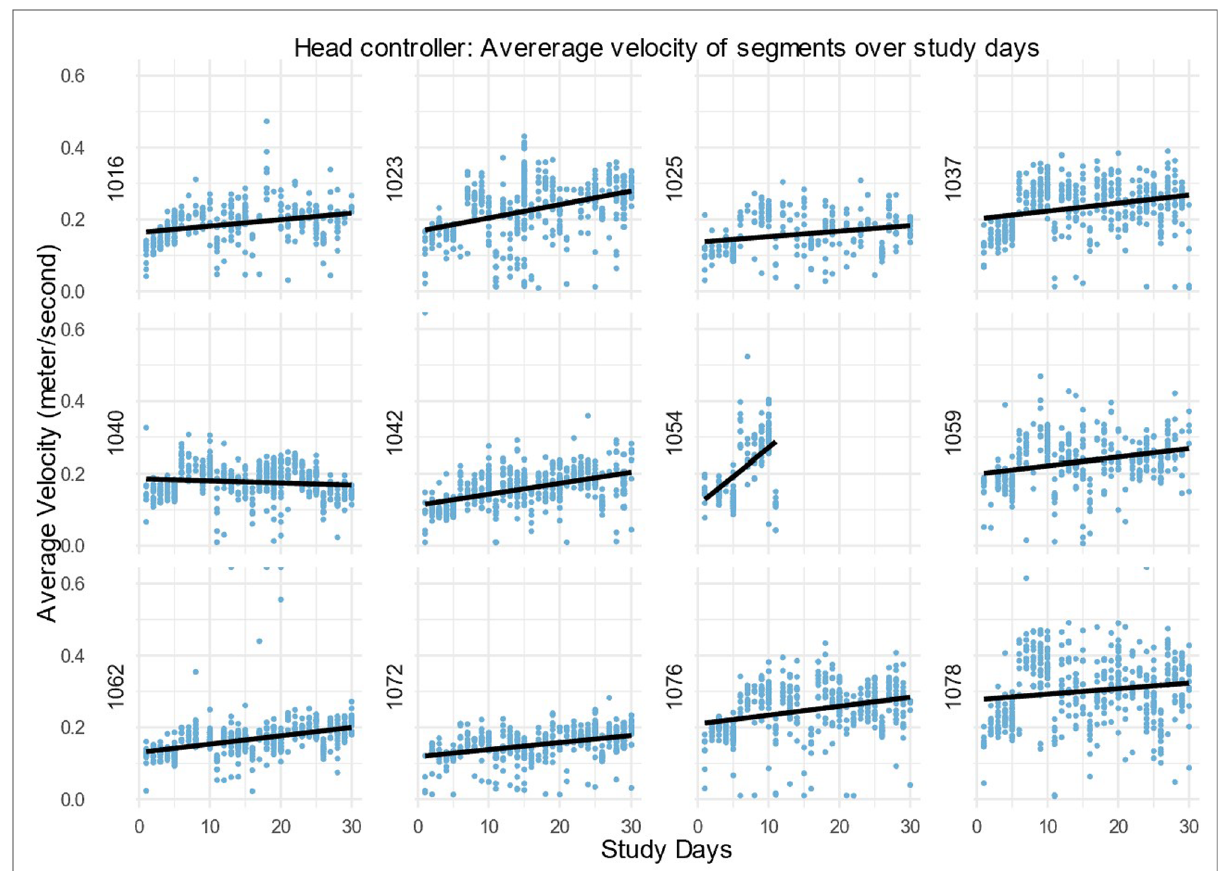
FIGURE 6 Average velocity in the head controller of all action task segments within the 30 daily sessions (m/s) for all DTxP arm participants, with the regression line over the